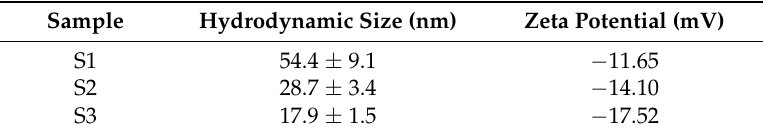
Table 2. Hydrodynamic diameter and zeta potential of green AuNPs synthesized using cacao